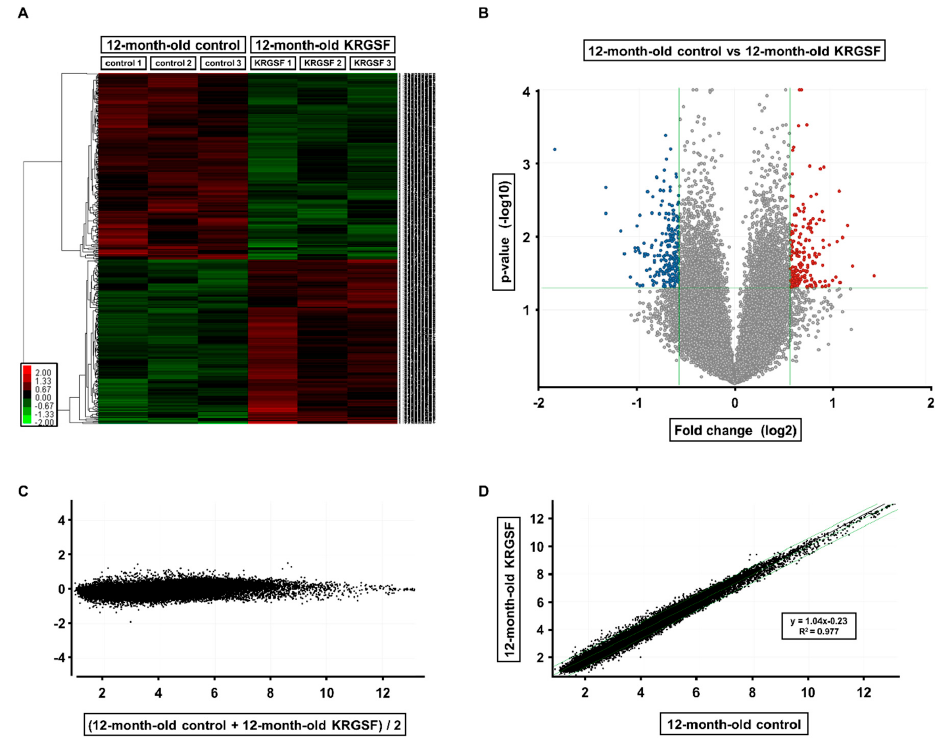
Figure 3. Gene expression in the ovaries of KRGSF-treated and untreated 12-month-old C57BL/6 mice: ( A ) hierarchical clustering and heat map analysis. A heat map of significantly differentially expressed (1.5-fold) genes is shown. Red dots represent higher expression and green dots represent lower expression at 12 months of age. Volcano plot ( B ) and scatter plots ( C , D ) of the microarray analysis data.